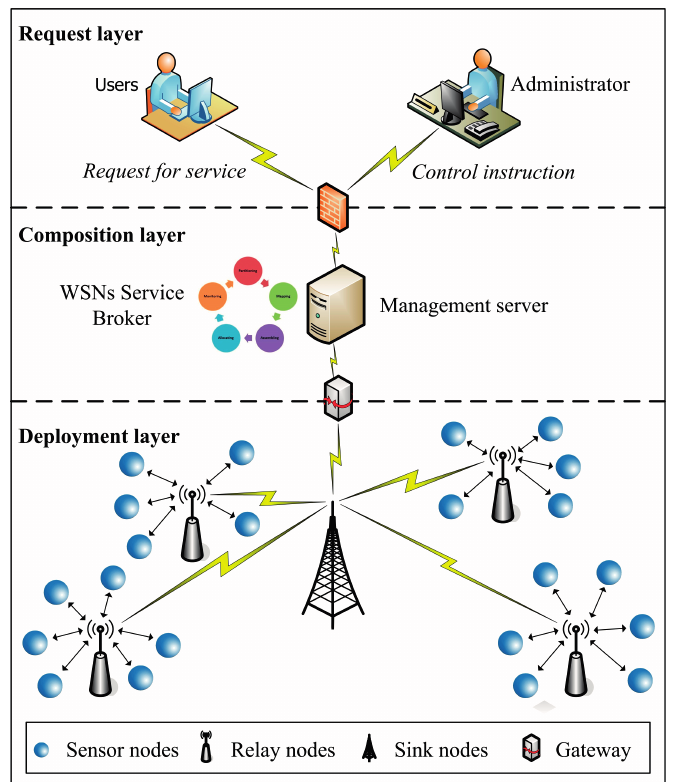
Figure 1. Architecture of SCAs in